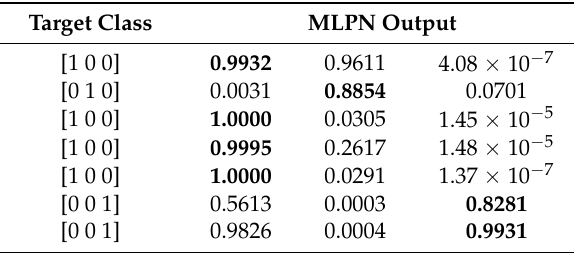
Table 6. Unknown data test output.